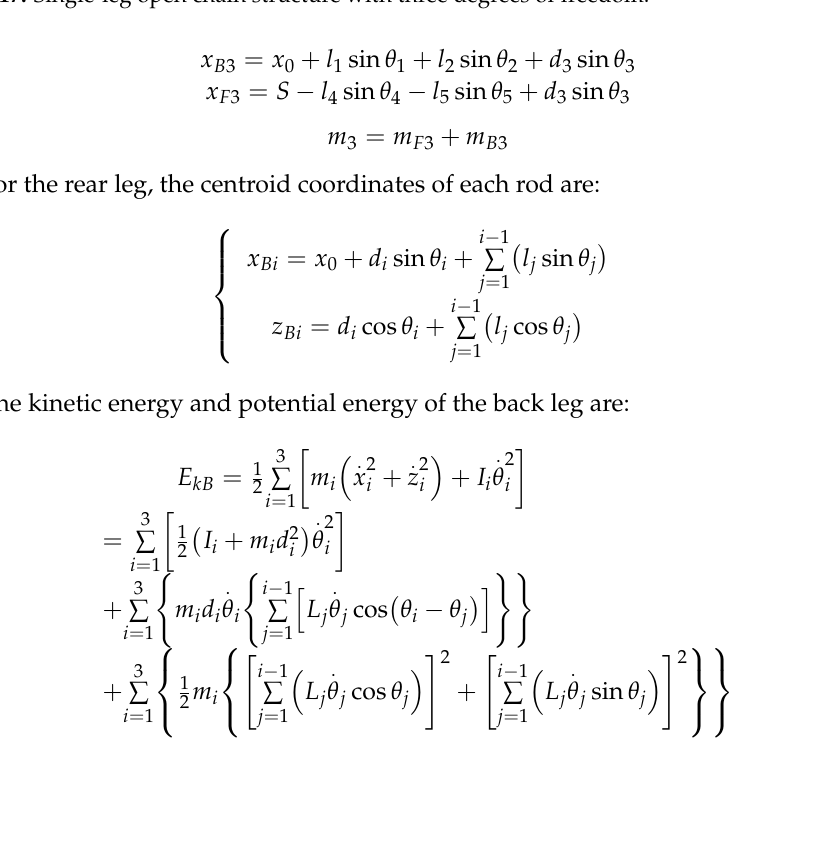
Figure 17. Single-leg open chain structure with three degrees of